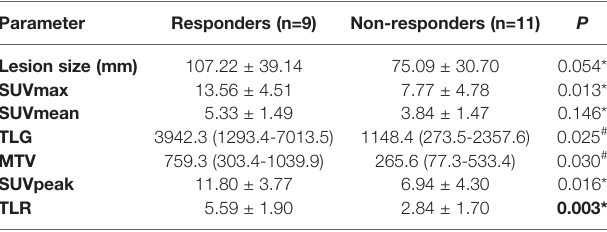
TABLE 2 | The value of pretreatment 18 F-FDG PET/CT parameters between responders and non-responders. Parameter